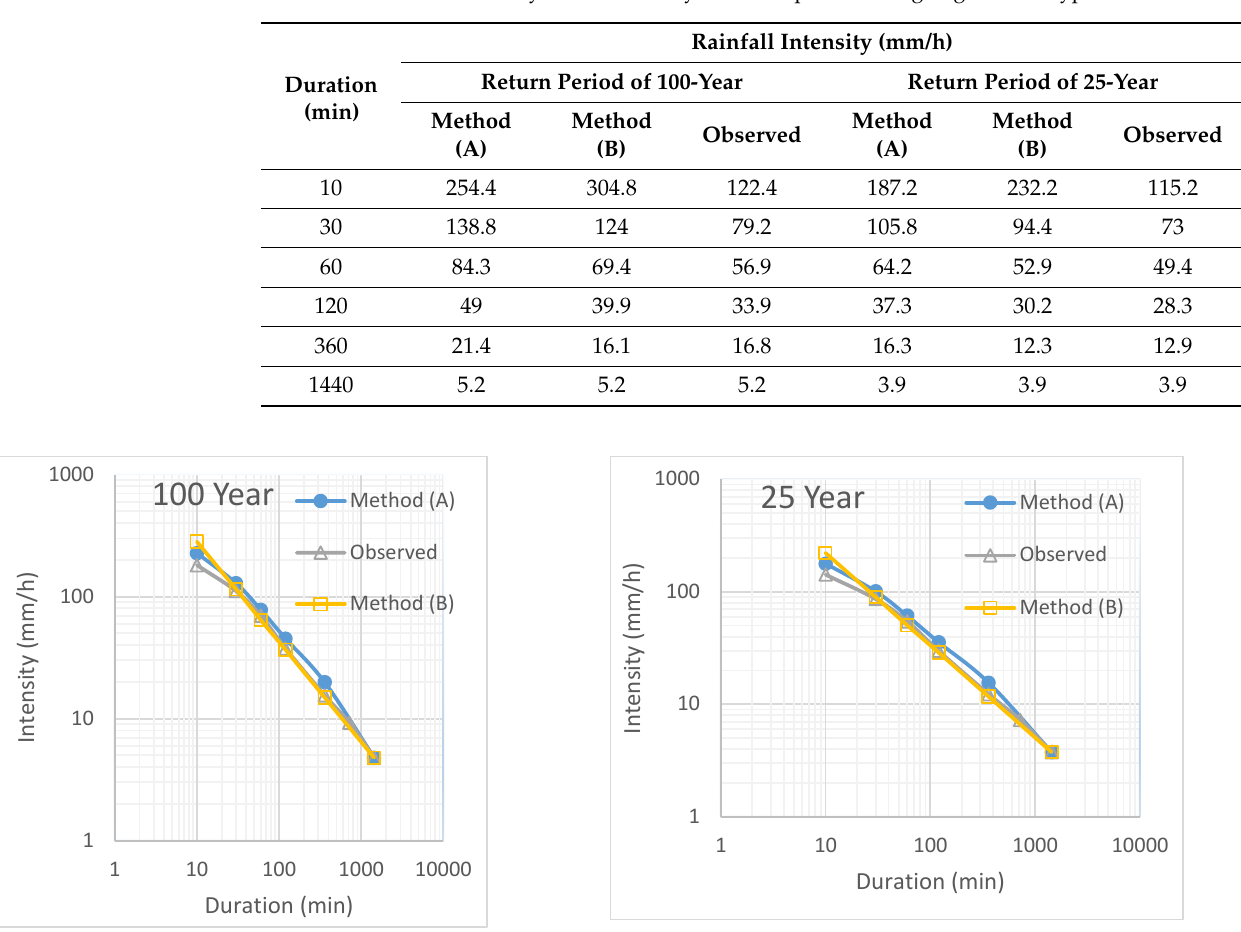
Figure 7. Comparison of IDF curves between two methods and observed with return periods 100 and 25 years using Gumbel distribution.